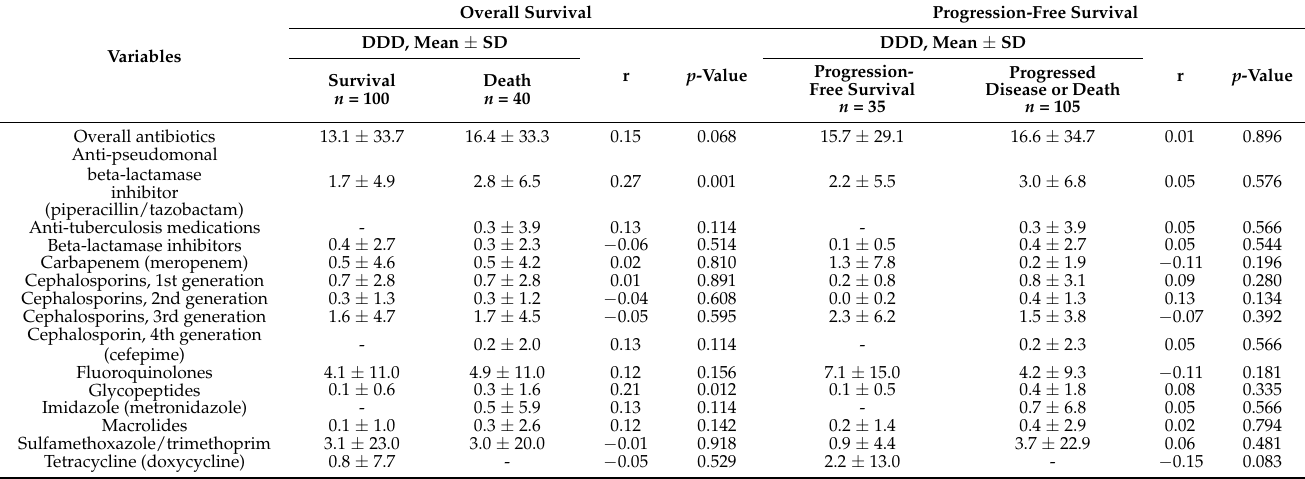
Table 3. Correlation between the defined daily dose (DDD) and overall survival and progression-free survival by antibi- otic class.